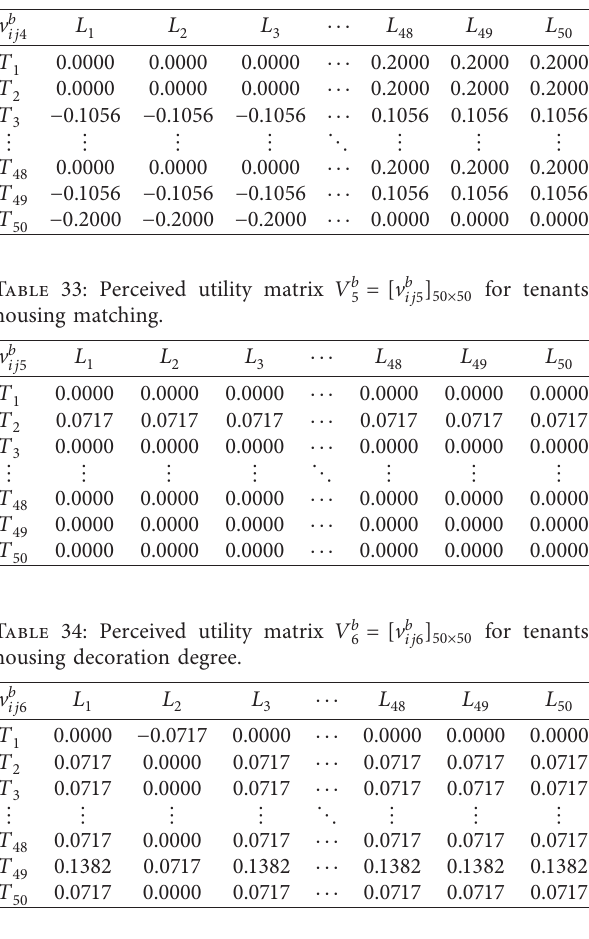
� [ v b ] for tenants’ ij 7 50 × 50 7